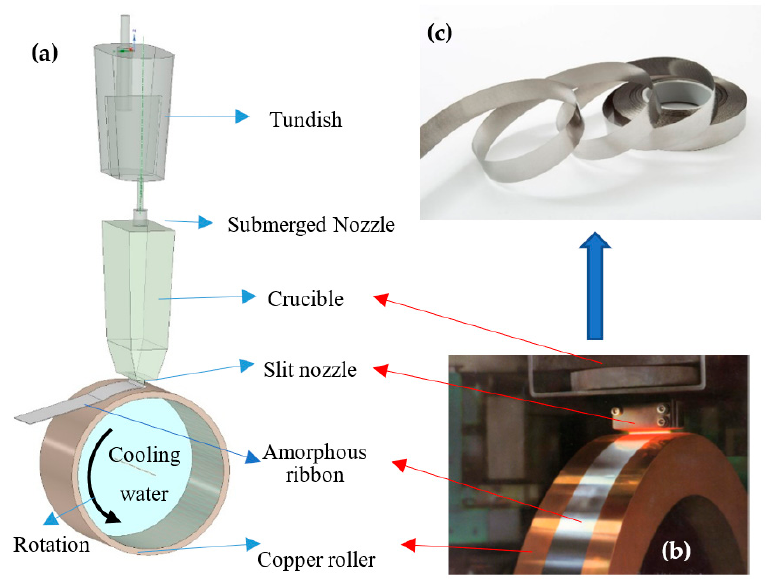
Figure 1. Overview of the PFC process. ( a ) Schematic diagram, ( b ) real process diagram, ( c ) amor- phous ribbon. (Figure 1b is reproduced from [7]).